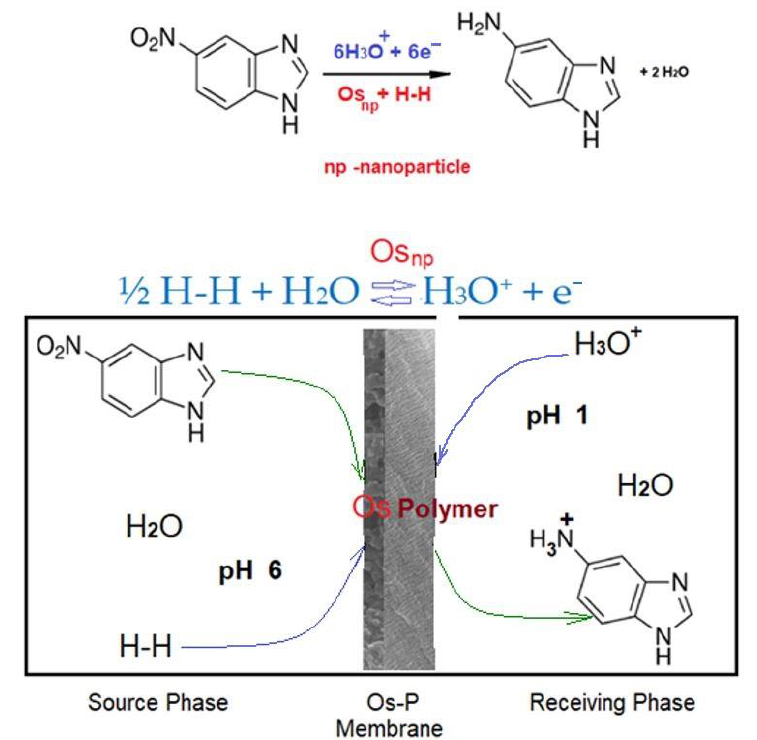
Figure 20. Proposed mechanism for transformation of 5–nitrobenzimidazol to 5–aminobenzimidazol in the reaction system using osmium – polymer (Os – P) membrane.